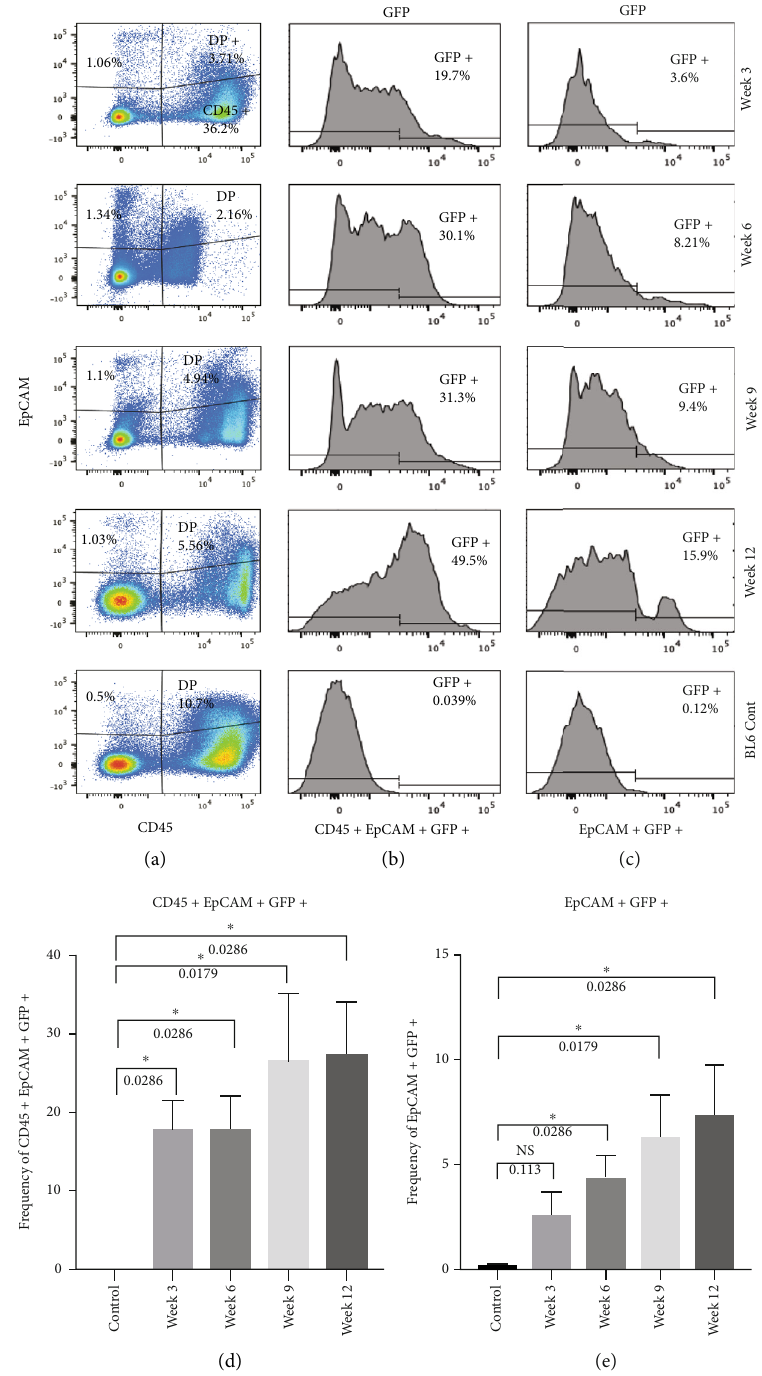
Figure 4: A peripheral population can contribute both CD45+ EpCAM+ cells and CD45-EpCAM+ TECs in the thymus. C57BL6 fetal thymi were transplanted under the kidney capsule of actin H2BGFP mice and analyzed for the presence of GFP-expressing cells at 4 time points 3 to 12 weeks after transplant using FACS. (a) The FACS representation of the lineage-depleted cells derived from dissociated engrafted thymi gated for CD45 and EpCAM. (b) The FACS representation of the percentage GFP+ cells within the CD45+ EpCAM+ subset found in the grafted thymus and (c) the FACS representation of the percentage GFP+ cells within the CD45- EpCAM+ population at the di ff erent time points after transplant under the kidney capsule. (d) Bar graph showing the mean percentage of the GFP-expressing cells found within the CD45+ EpCAM+ cell population at di ff erent time points (error bars represent SEM). (e) Bar graph showing the mean percentage of the GFP-expressing cells found within the CD45- EpCAM+ TEC population at di ff erent time points (error bars represent SEM). “ ∗ ” indicates a statistically signi fi cant di ff erence between control and any time point. P values for each t -test analysis are given with the bar graph. The results presented are representative of the three to fi ve replicates of each experiment that were